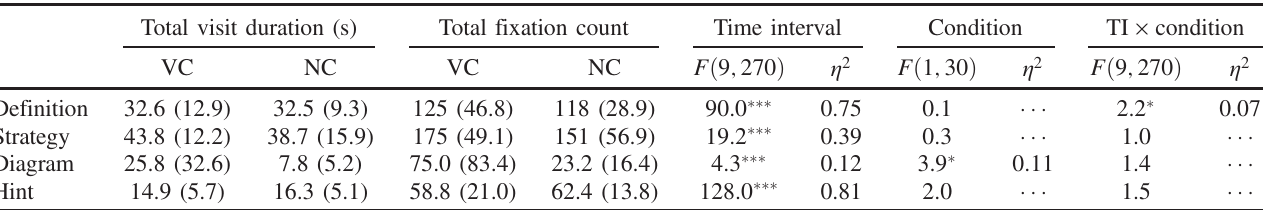
TABLE III. Attention measures on each AOI per group and results of four repeated measures ANOVAs ( 10 × 2 ) with “ condition ” as between-subjects factor and “ time interval ” (TI) as within subjects factor.